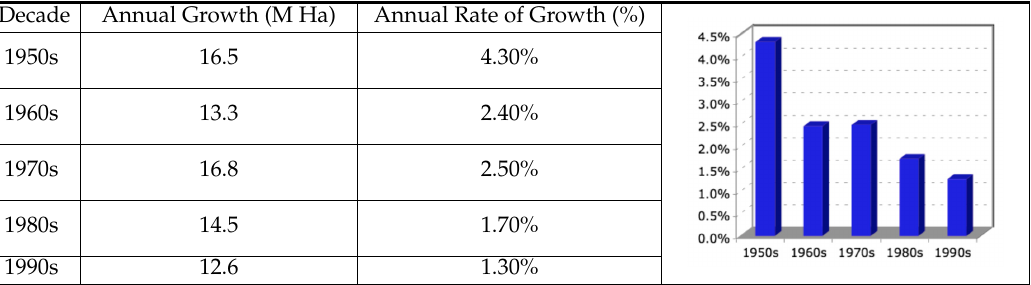
Figure 22. Area equipped for irrigation between 1900–2000 for the four major irrigated countries and the rest of the world (adapted from [145]). Table 1. Growth in irrigated areas from 1950s to 1990s (adapted from [147]).